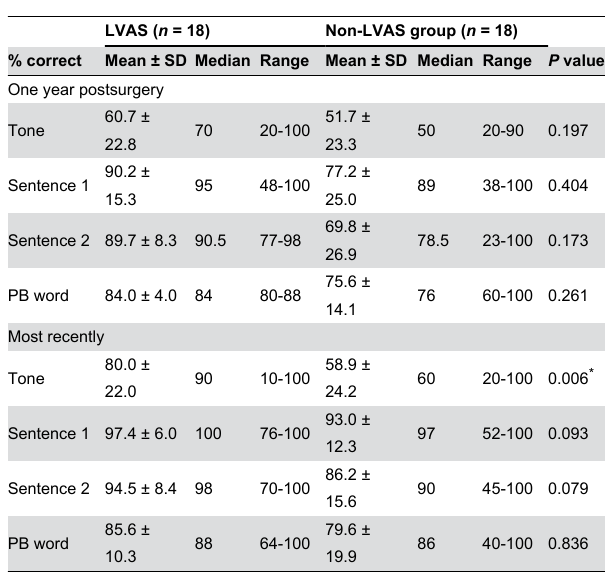
Table 8. Comparison of speech perception test scores obtained by patients more than five years after implantation and most recently between the LVAS and non-LVAS